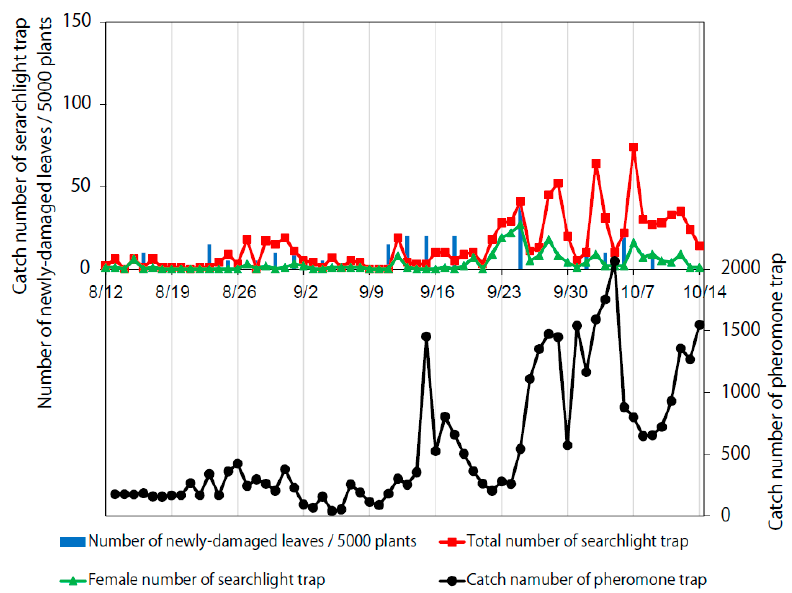
Figure 3. Temporal variation of S. litura catch numbers caught by the searchlight and pheromone traps, and numbers of newly damaged leaves per 5000 soybean plants in 2017.